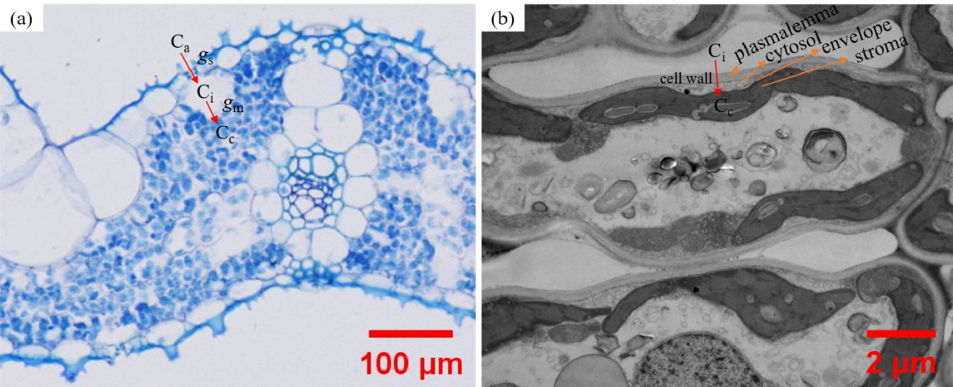
Figure 2. The diffusing pathway of CO 2 from the atmosphere to the chloroplast. ( a ) The light microscope image of rice leaf and ( b ) the transmission electron microscope image of rice leaf. C a , atmospheric CO 2 concentration; C i , intercellular CO 2 concentration; C c , chloroplastic CO 2